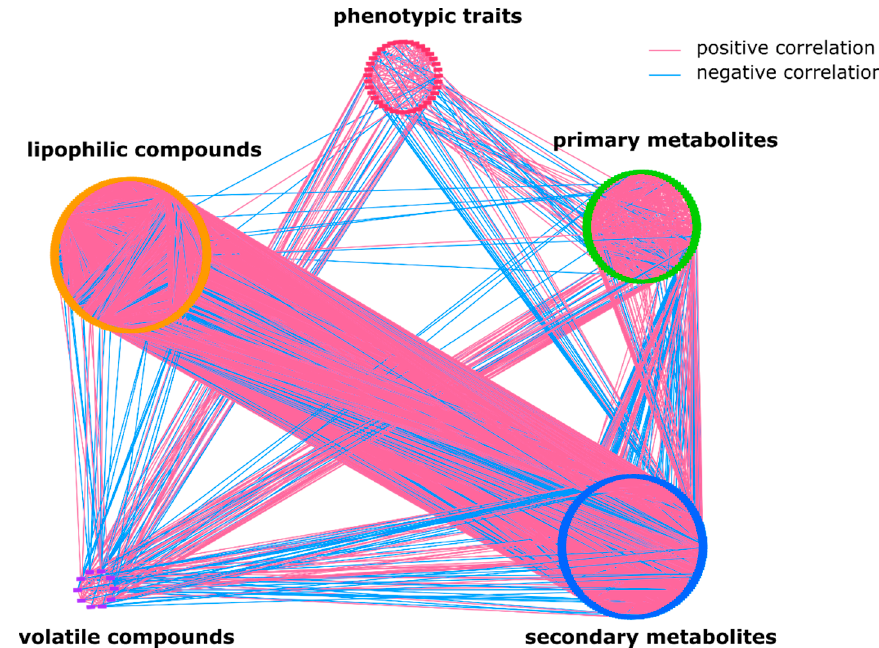
Figure 1. Overall metabolic network. Each node represents a metabolite or a whole plant phenotypic trait; edges connecting two nodes show an association between two traits. In total, the network is composed of 455 nodes and about 15,000 edges assembled into five large groups: lipophilic metabolites comprise of 171 nodes, primary and secondary metabolites have 89 and 147 nodes, respectively, phenotypic traits have 38 nodes, and the smallest group consists of 10 nodes and represents volatile compounds (Supplementary material Table S1).